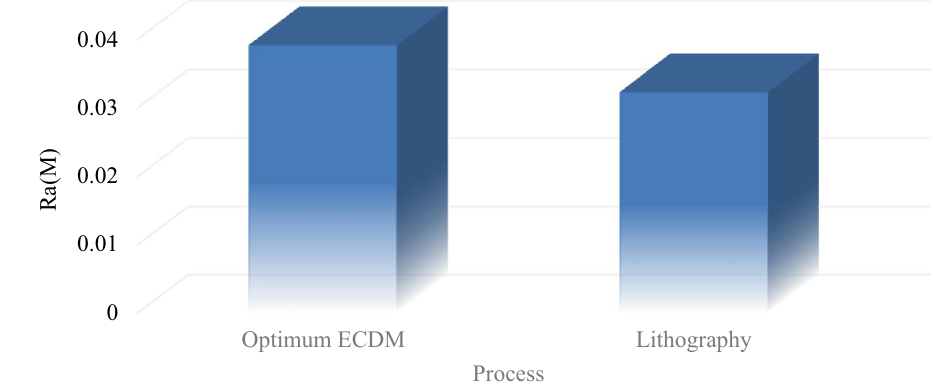
Fig. 14 Comparison of surface roughness of channel created by lithography with channel created by ECDM in best